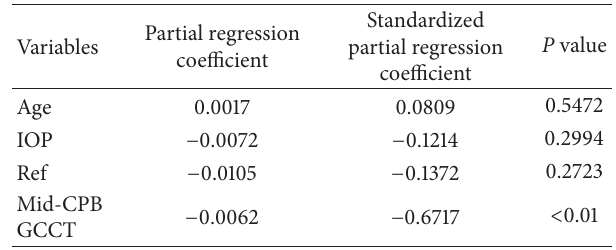
Table 4: Results of multiple regression analysis for factors indepen- dently impacting best-corrected visual